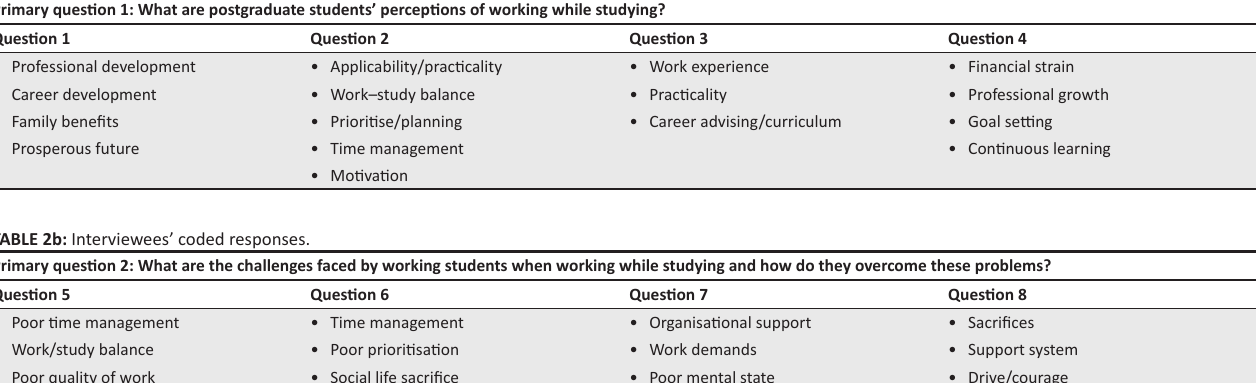
TABLE 2a: Interviewees’ coded responses.